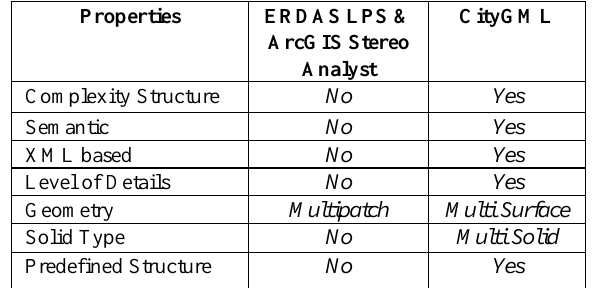
Table.1: It shows the differences between ERDAS LPS